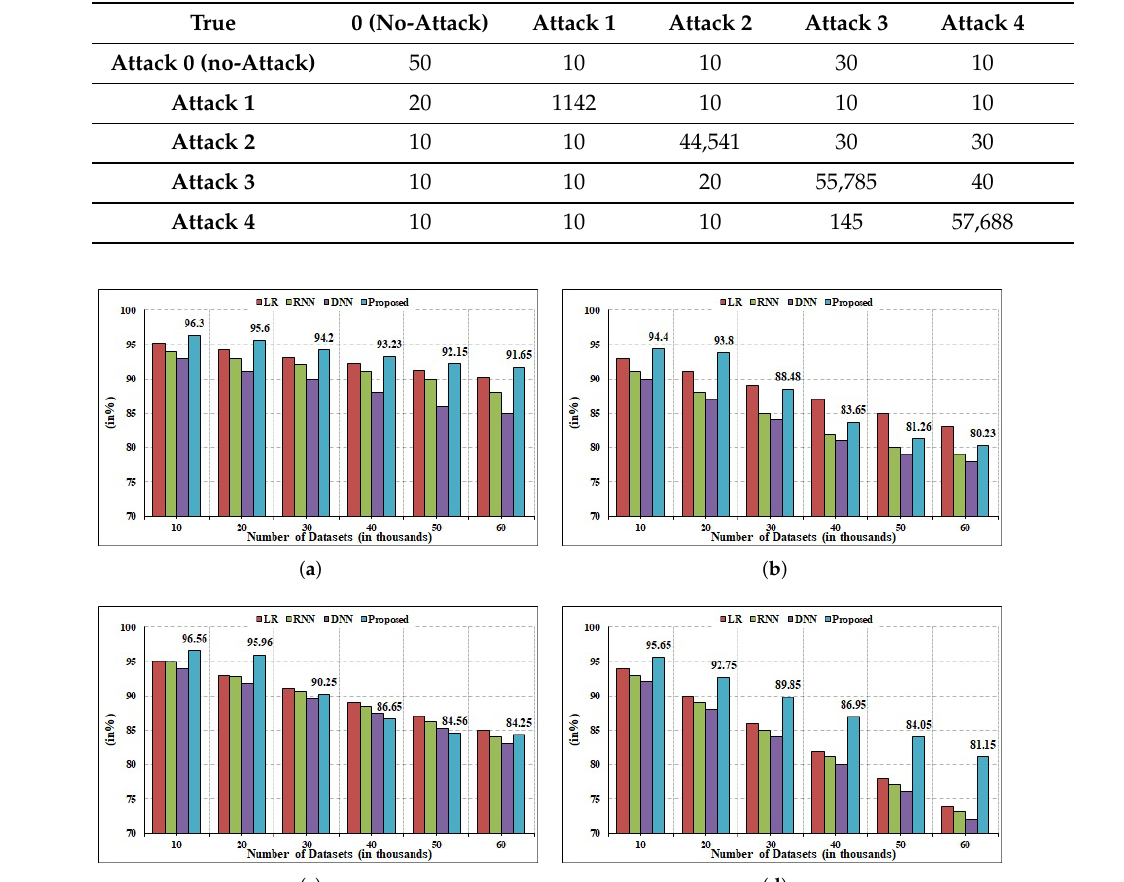
Table 7. Confusion Matrix.